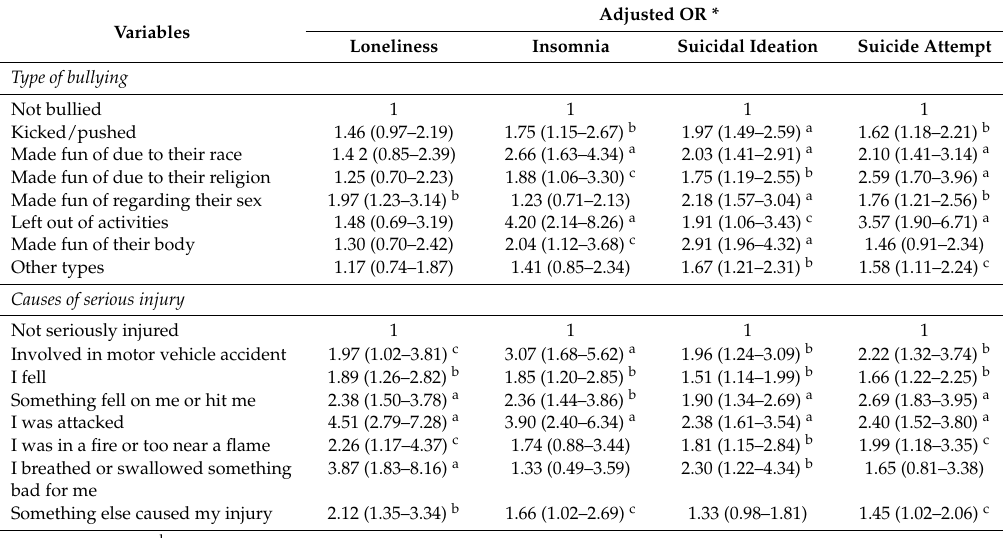
Table 5. Association of bullying types and injury causes with psychological health outcomes. Adjusted OR * Variables Loneliness Insomnia Suicidal Ideation Suicide